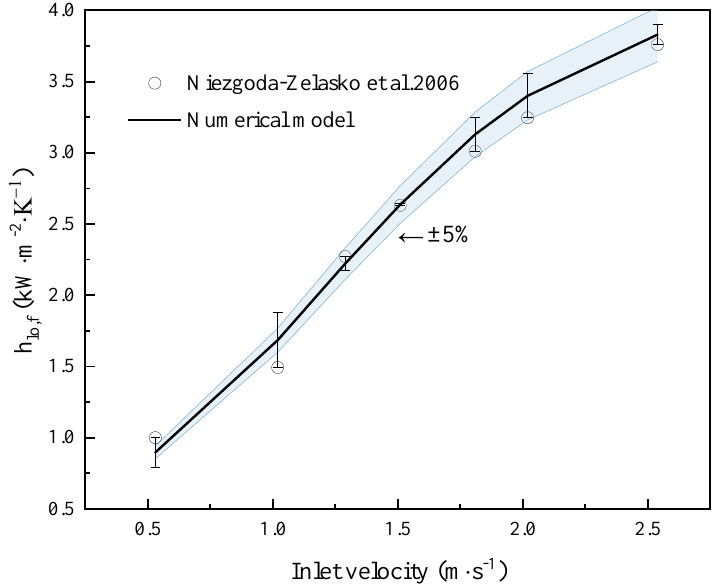
Figure 6. Comparison of predicted results of heat transfer coefficient with the experimental results of Niezgoda-Zelasko [16].